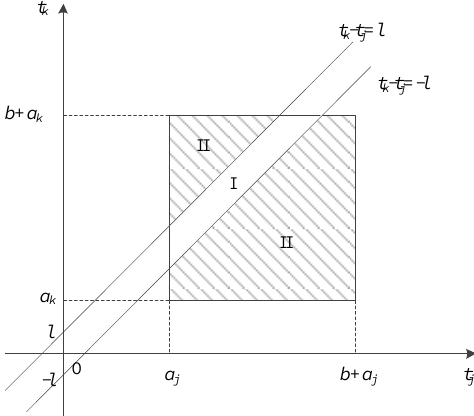
Figure A1. A section of the collision and collision-free parts on the t j − o − t k plane.